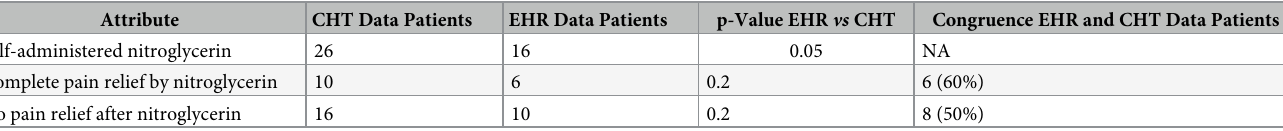
Table 7. Use and effect of self-administered